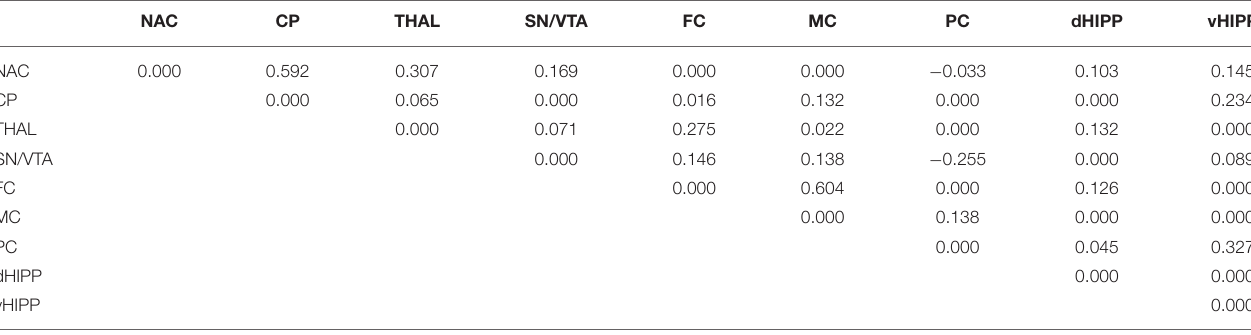
TABLE 3 | Path coefficient matrix after treatment with saline obtained with EBICglasso modeling of D 2 / 3 R binding potentials in nucleus accumbens (NAC), caudate putamen (CP), thalamus (THAL), substantia nigra/ventral tegmental area (SN/VTA), frontal cortex (FC), motor cortex (MC), parietal cortex (PC), dorsal hippocampus (dHIPP), and ventral hippocampus (vHIPP).